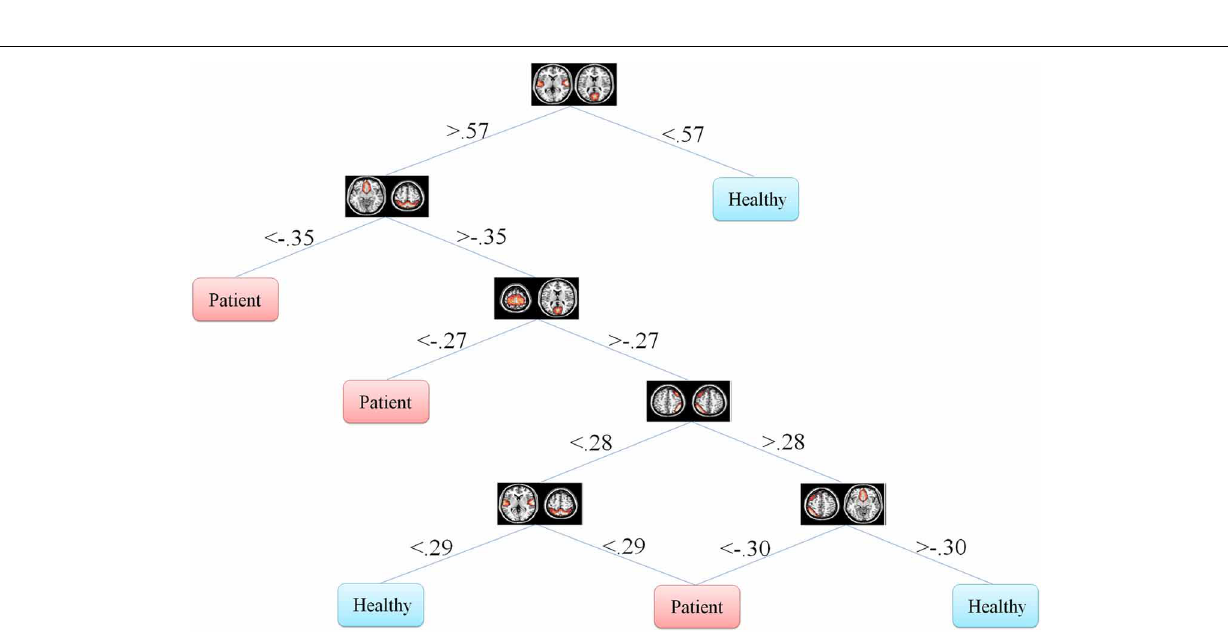
FIGURE 6 | Information gain decision tree using full set of features. This tree includes six features in six